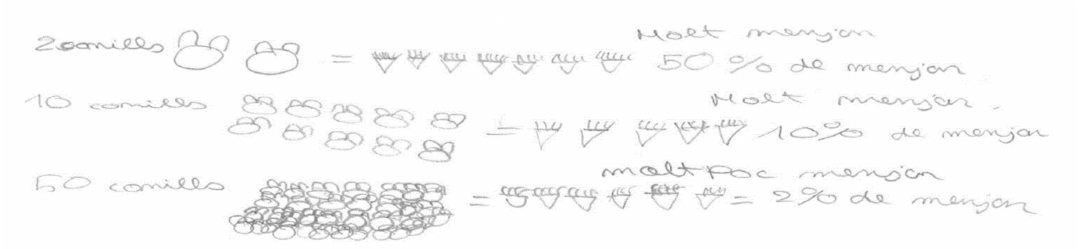
Figure 8. Pupil 6 (cid:48) s symbolic support for the argument of the inverse relationship between the number of rabbits and the quantity of food available for each